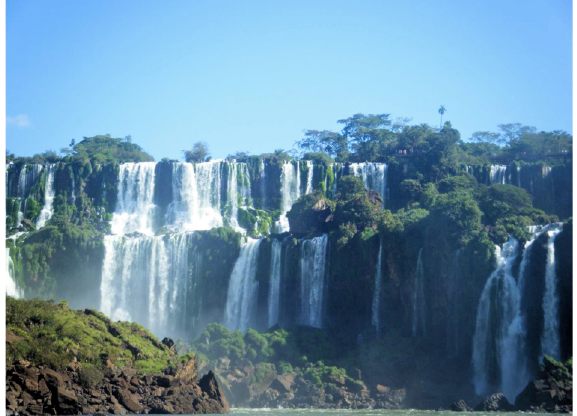
Fig. 2. The Iguazu Falls on the border of Argentina and Brazil. Photo courtesy of Alice Goudie, April 2013.